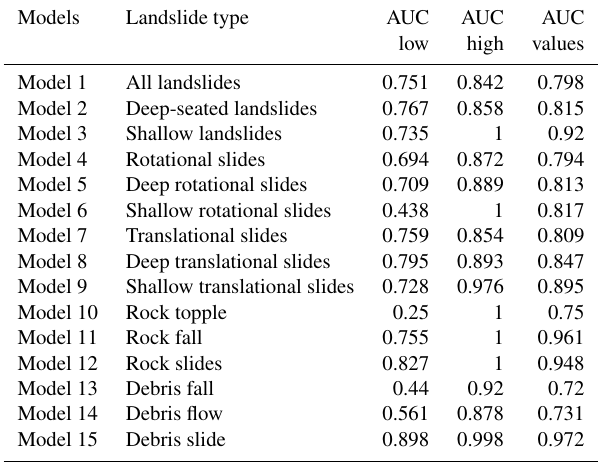
Table 6. AUC values obtained in the validation process for all mod-